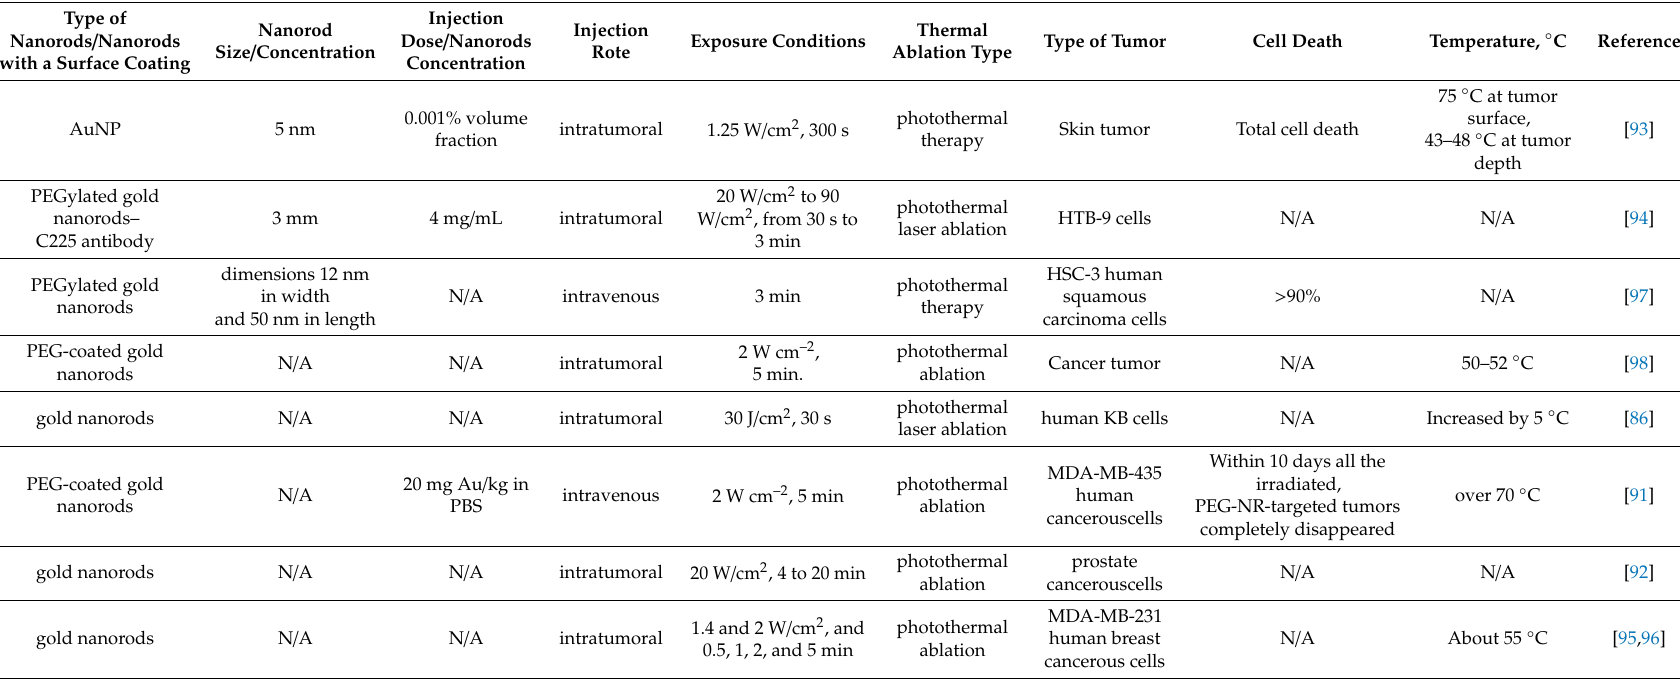
Table 4. Summary of nanorods application in the thermal ablation of cancer (PEG: polyethylene